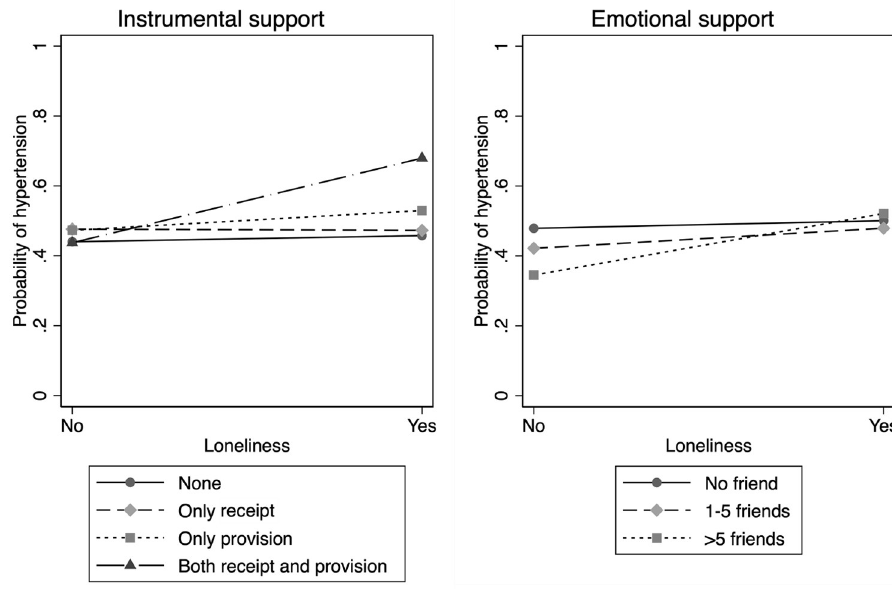
Fig 1. Interaction of the relationship between loneliness and social support on hypertension. Models are controlled for age, sex, body mass index, marital status, educational attainment, alcohol consumption, smoking, and physical activity. The y-axis represents predicted